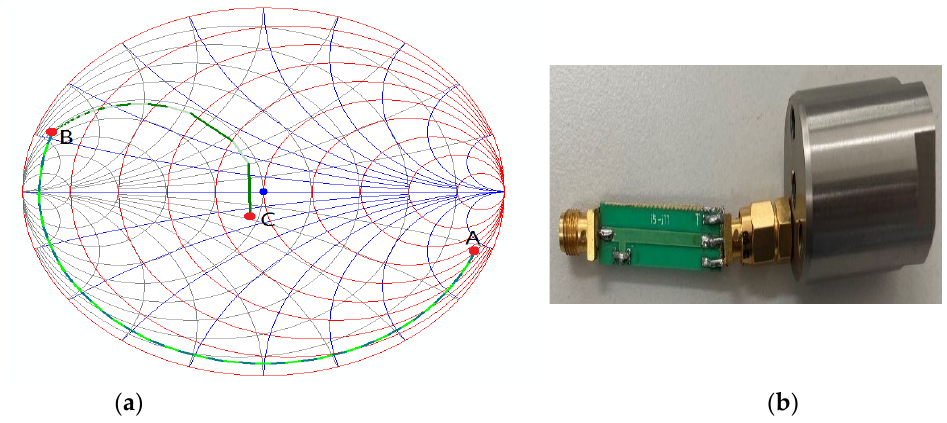
Figure 6. Antenna impedance matching and physical image: ( a ) impedance matching process using a microstrip line and a parallel capacitor; ( b ) physical image of the antenna and matching circuit.